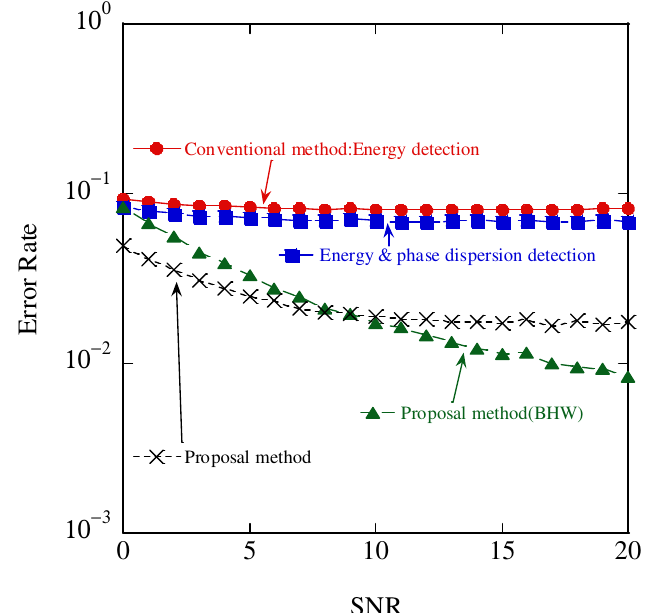
Figure 16. Aggregate accuracy